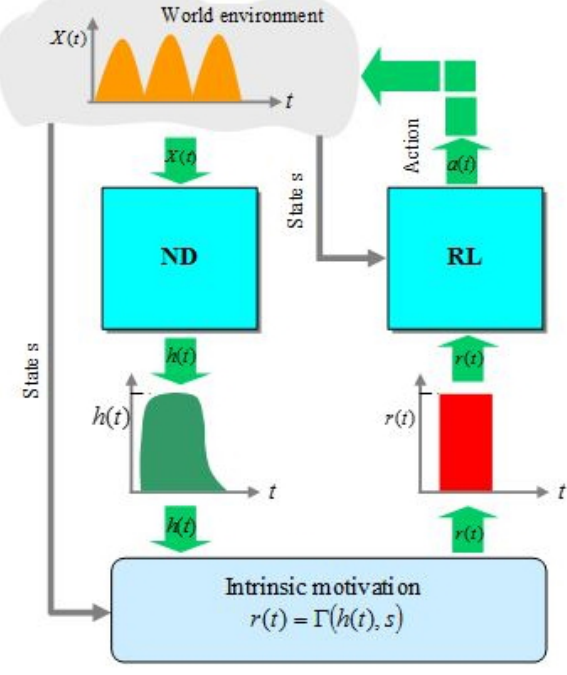
Figure 8: An Integrated model based on the tri-partite relationship between ND, IM and